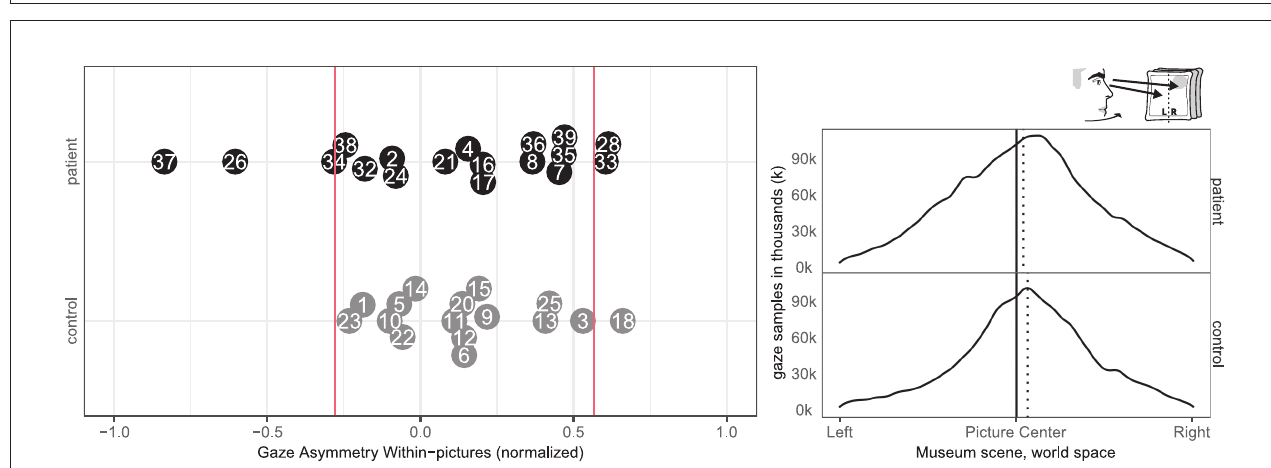
FIGURE 4 | Gaze Asymmetry Between-pictures. (Left) Individual normalized time difference between looking at left/right picture in patient (black, top) and control (gray, bottom) with normative threshold cut-offs (red lines). (Right) Patient (black, top) and control (gray, bottom) histograms of horizontal gaze sample positions limited to the left and right painting with the true (solid) midline and the (dotted) group median of horizontal gaze positions.